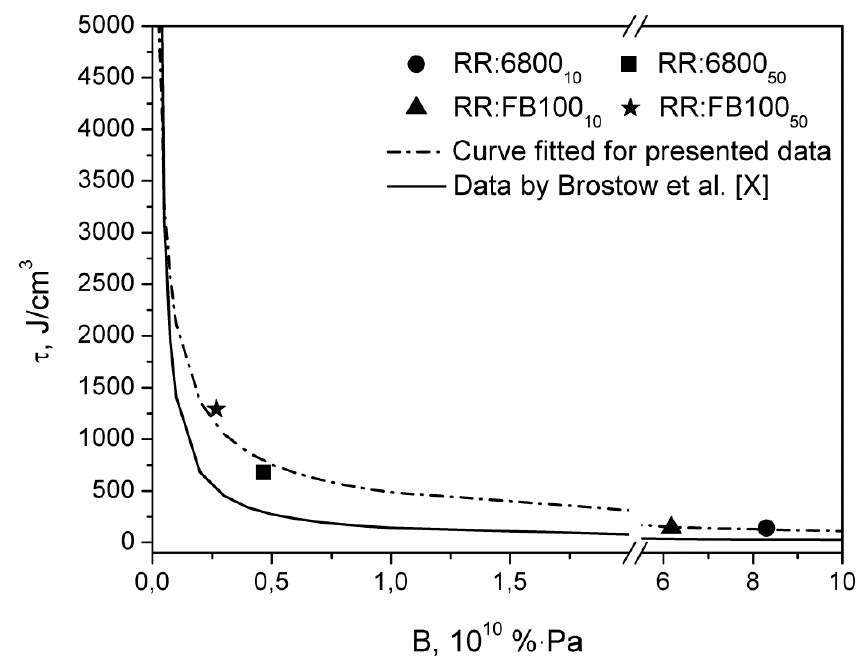
Figure 4. Relationship between toughness and brittleness of analyzed materials.